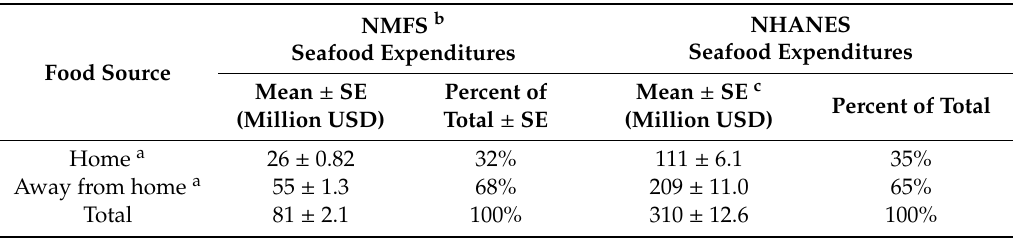
Table 5. Seafood expenditure by food source modeled using supply (NMFS) and consumption data (NHANES)